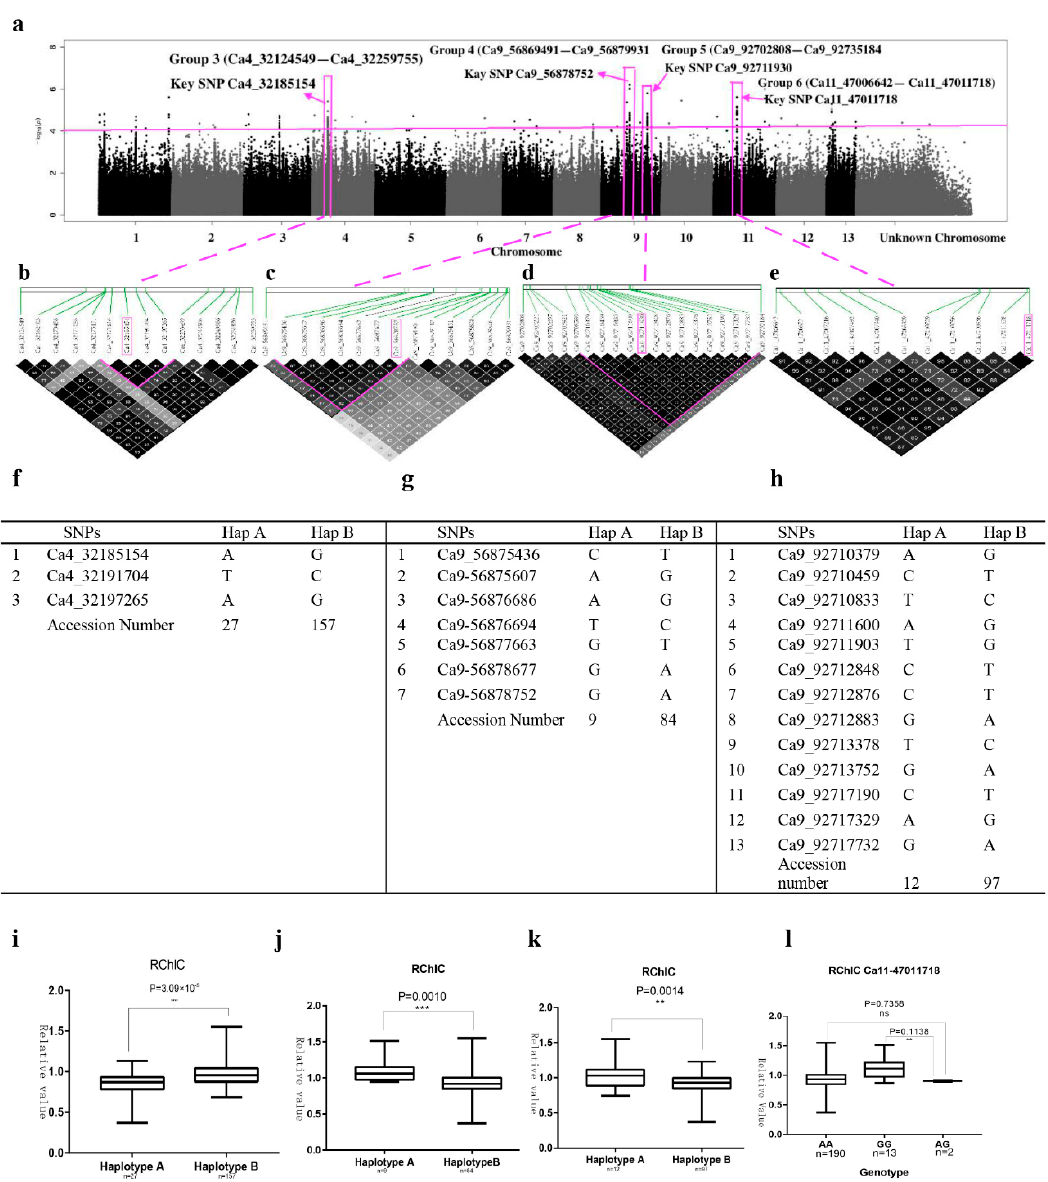
Figure 4. GWAS results for RChlC and analysis of the peaks on chromosome 4, 9 and 11. ( a ) Manhattan plot for RChlC. The horizontal line represents the significant threshold ( − log 10 P = 4). The pink color surrounds represent SNP rich regions (Group 3, Group 4, Group 5 and Goup 6). ( b ) LD surrounding the peak of Group 3. ( c ) LD surrounding the peak of Group 4. ( d ) LD surrounding the peak of Group 5. ( e ) LD surrounding the peak of Group 6. ( f ) Haplotypes in Group 3. ( g ) Haplotypes in Group 4 ( h ) Haplotypes in Group 5. ( i ) Phenotypic di ff erences of RChlC between two haplotypes in Group 3. ( j ) Phenotypic di ff erences of RChlC between two haplotypesin Group 4. ( k ) Phenotypic di ff erences of RChlC between two haplotypesin Group 5. ( l ) Phenotypic di ff erences for RChlC based on the key SNP (Ca11_47011718) of Group